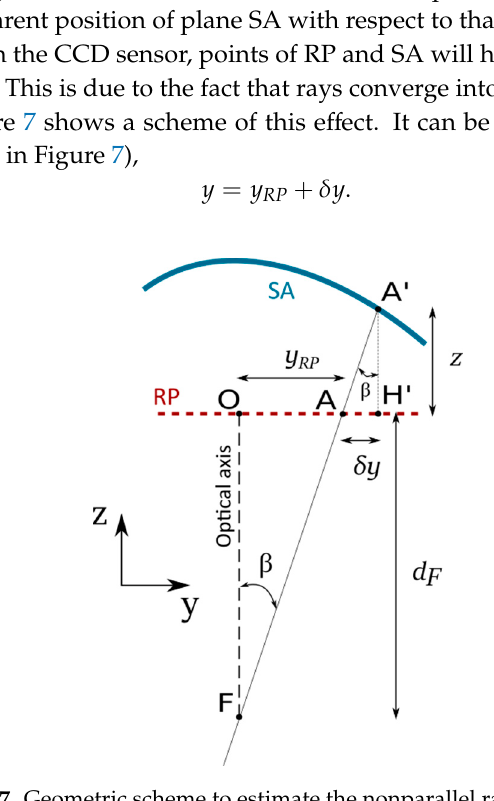
Figure 7. Geometric scheme to estimate the nonparallel ray correction.